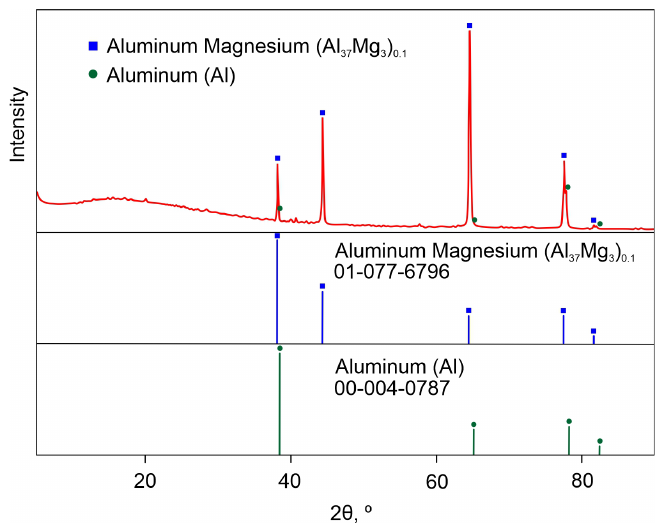
Figure 3. XRD pattern of PEO-coated aluminum sample. Table 1. Binding energy (eV) and elemental composition (at. % in parentheses) of the surface of CC-1,2,4-tr-24